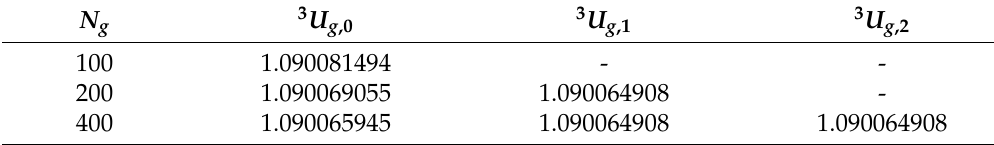
d 2 u ( 0 ) with β = dx 2